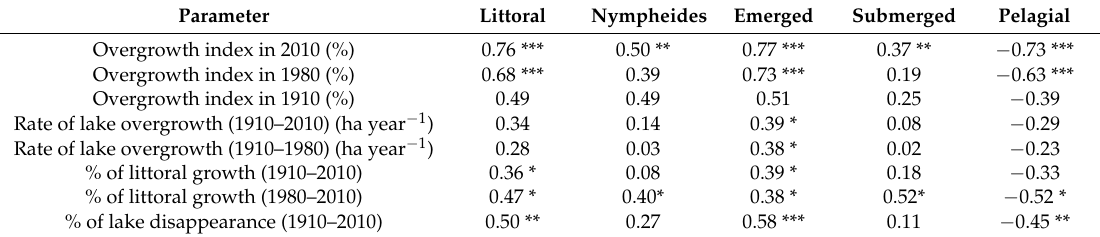
Table 2. Results of Spearman rank correlation between analyzed parameters of lake changes